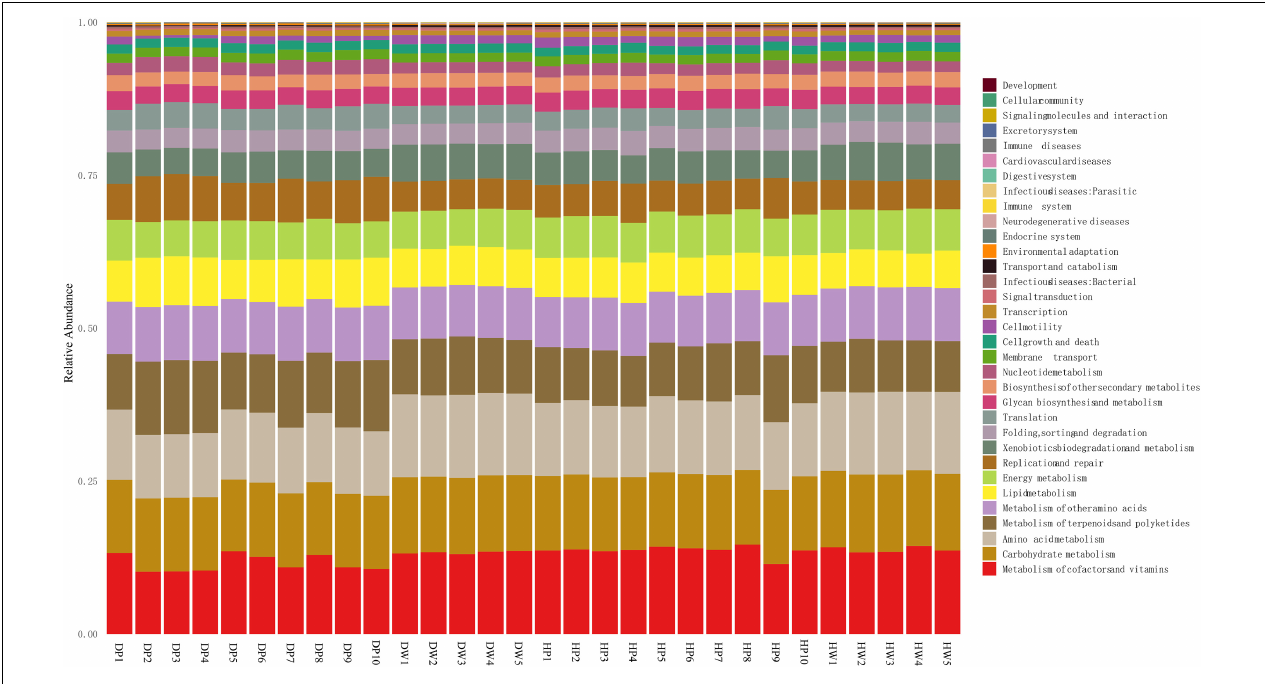
FIGURE 7 | COG function classification of DP, DW, HP, and